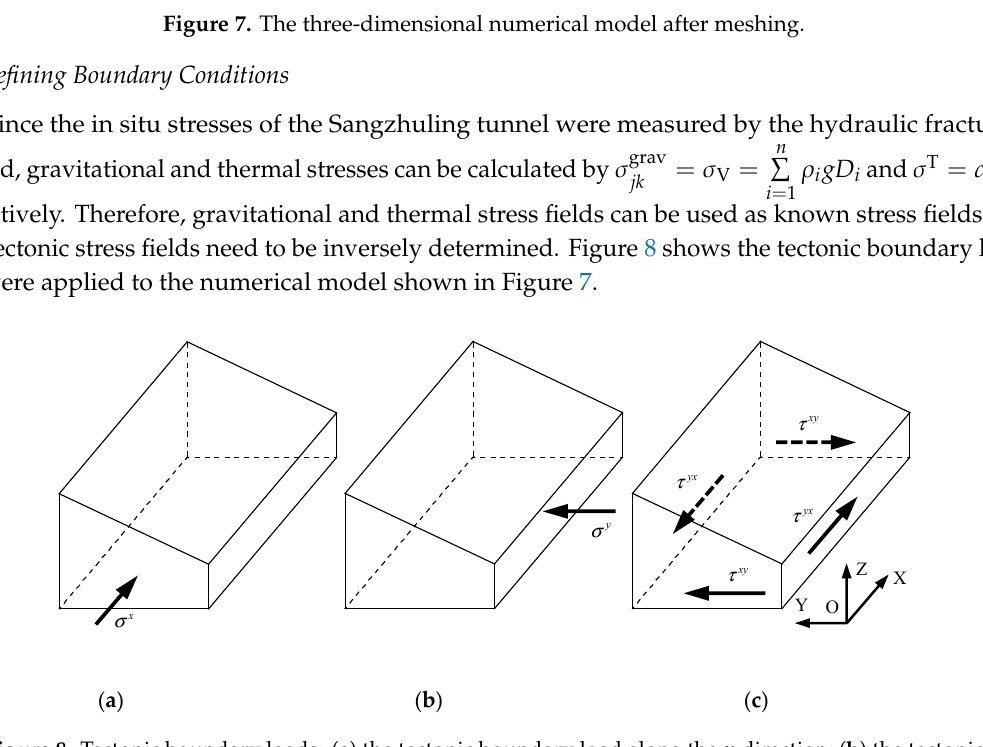
Figure 8. Tectonic boundary loads: ( a ) the tectonic boundary load along the x -direction; ( b ) the tectonic boundary load along the y -direction; ( c ) the tectonic shear loads in the xy plane.